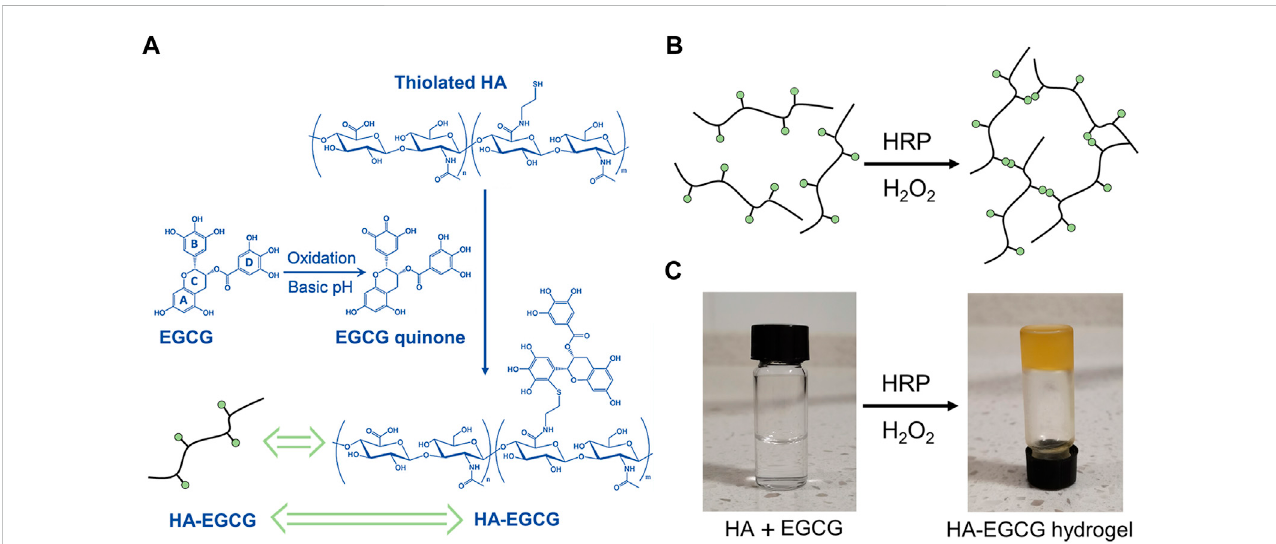
FIGURE 1 Preparation of HA-EGCG hydrogel. (A) Synthetic scheme of HA-EGCG conjugate. (B) Schematic diagram illustrating the formation of HA-EGCG hydrogel through oxidative coupling between two EGCG moieties catalyzed by HRP and H 2 O 2 . (C) Gross images of HA-EGCG conjugate solution (left) and HA-EGCG hydrogel (right) catalyzed by HRP and H 2 O 2 .